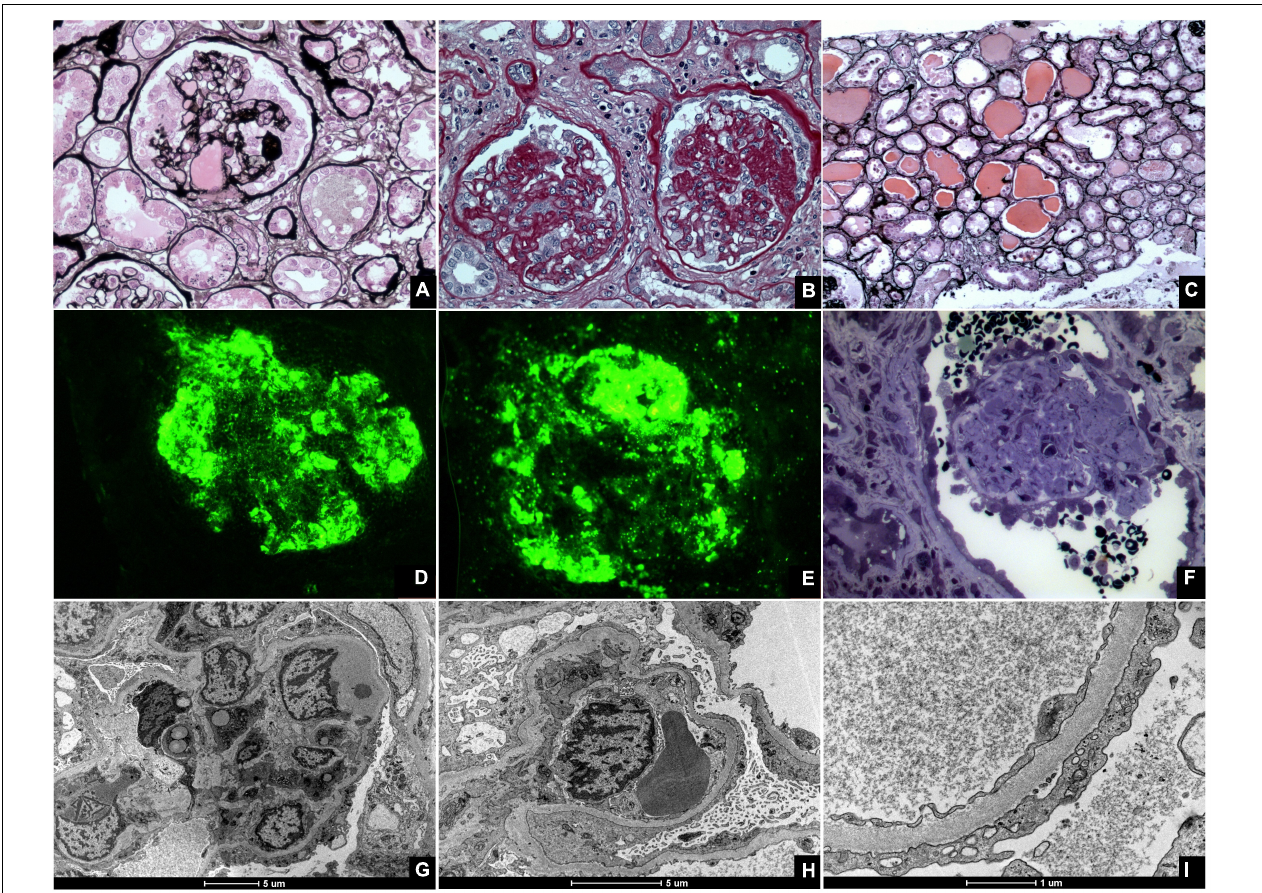
FIGURE 3 | Kidney biopsies of collapsing glomerulopathy. (A,B) Periodic Acid Schiff (PAS) and Jones Methenamine Silver (JMS) (40 × ), respectively show intense podocyte hyperplasia and glomerular tuft collapse. (C) JMS (20 × ) exhibits microcytic transformation of distal convoluted tubules with accumulations of hyaline material inside of those. (D,E) Fluorescence microscopy (40 × ) shows, respectively, IgM and C3 trapping in areas of collapse/sclerosis. (F) Semi-fine stained in Toluidine Blue (63 × ) with collapse of the entire glomerular tuft and hyperplasia of podocytes and dilated Bowman’s space. (G,H) Transmission electron microscopy contrasted with Osmium Tetroxide, Lead Citrate and Uranyl in block shows capillary loop collapse with hyalinosis in addition to diffuse fusion and flattening of the pedicels associated with microvillous transformation. (I) Electron microscopy tubes contrasted with osmium tetroxide, lead citrate, and uranyl in block with detail of disorganization of the cytoskeleton in the podocyte cytoplasm, with extensive effacement of the pedicels.